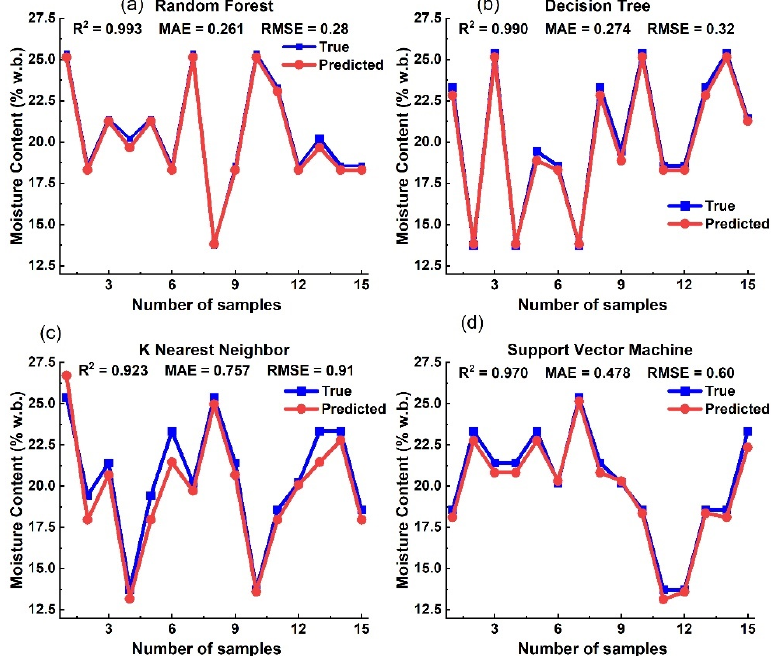
Figure 13. Prediction results of four algorithms: ( a ) results based on random forest; ( b ) results based on decision tree; ( c ) results based on k-nearest neighbor; ( d ) results based on support vector machine.